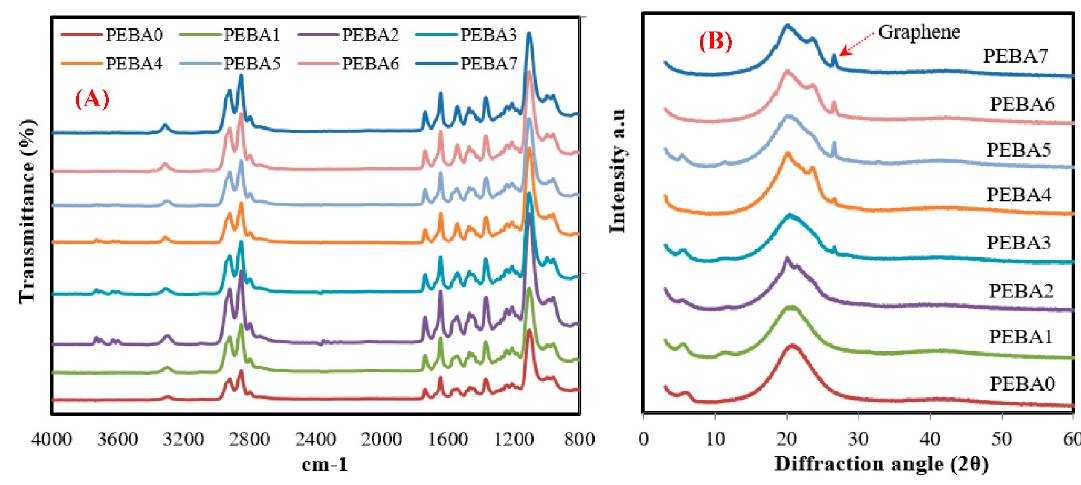
Figure 6. ( A ) FTIR and ( B ) XRD analysis of the synthesized membranes .